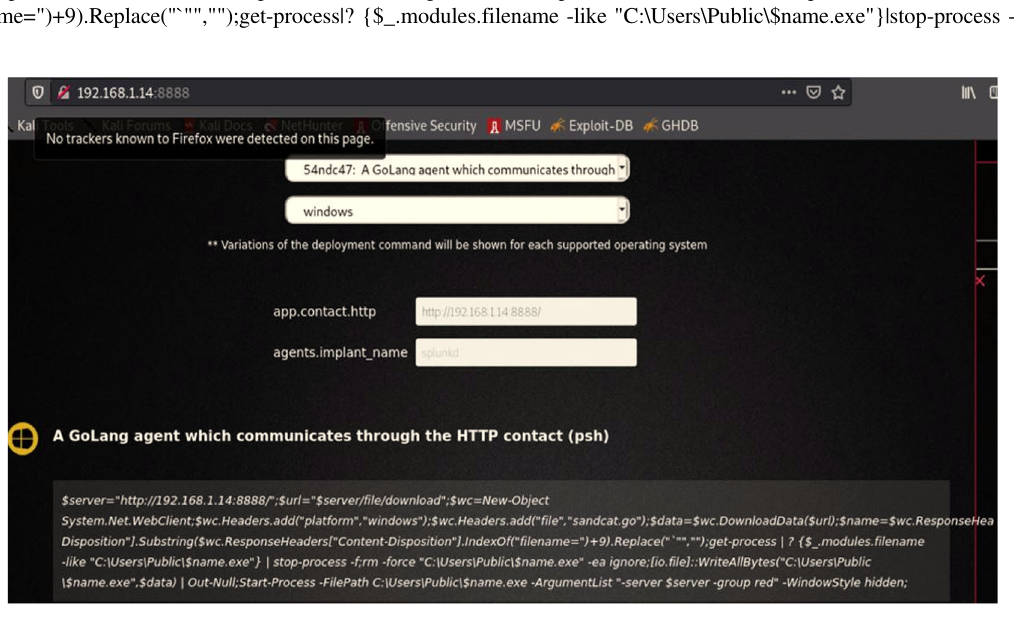
Figure 5. Creating an agent for a specific OS.